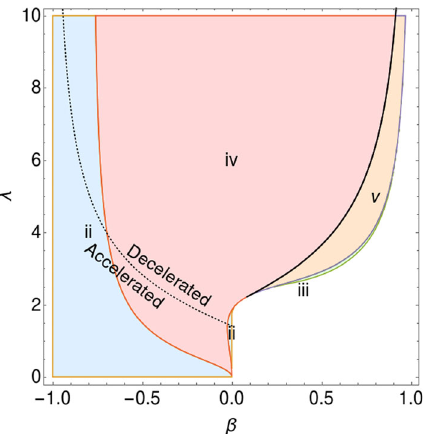
Fig. 2 Part of the region of existence of solution of the critical point E − . The region ii contains stable points, iii unstable points, iv spiral stable points, v spiral unstable points and center points on black line. The black dotted line divides accelerated and decelerated critical points